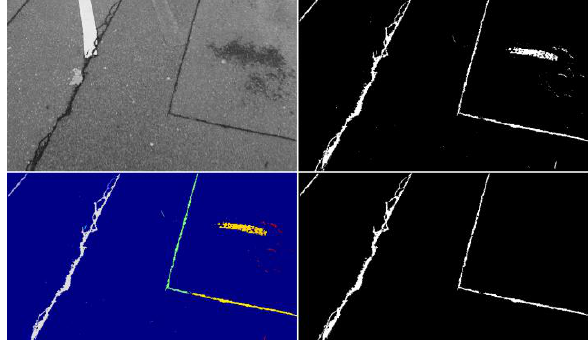
Figure 8. Greyscale image (upper left), binary result of crack detection (upper right), connected regions as symbolic image (lower left), binary image filtered by the roundness criterion (lower right). Figure 10. Flowchart of rut detection using laser